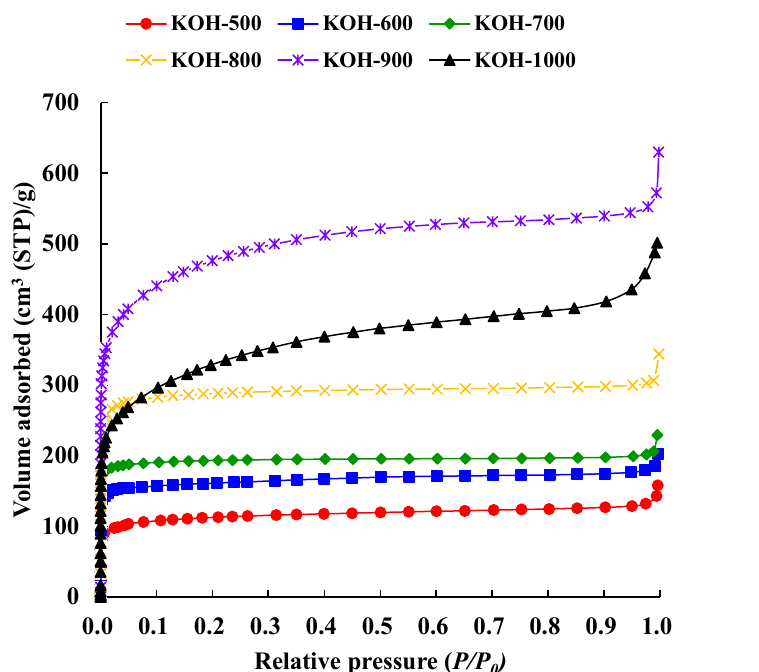
Figure 2. N 2 adsorption isotherms of KOH ACs prepared at different activation temperatures.